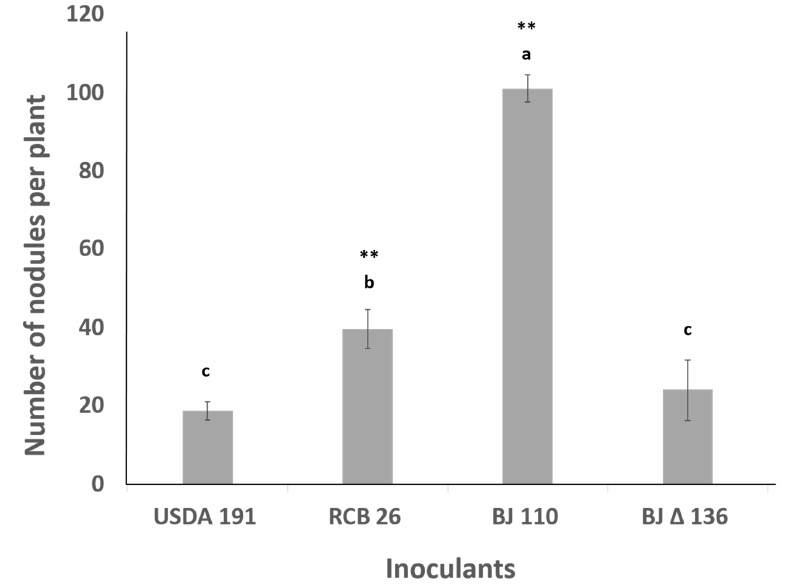
Figure 3. Nodulation of pigeon pea by B. diazoefficiens USDA110, S. fredii USDA191, and T3SS mutants. The bars represent the total number of nodules per plant and standard errors are indicated above bars. Bars with same letter are not significantly different. Values are presented as mean ± SD ( n = 12). Double asterisks (**) indicate significance at the p < 0.01 level. Letters indicate the result of Tukey–Kramer test for significant ANOVA